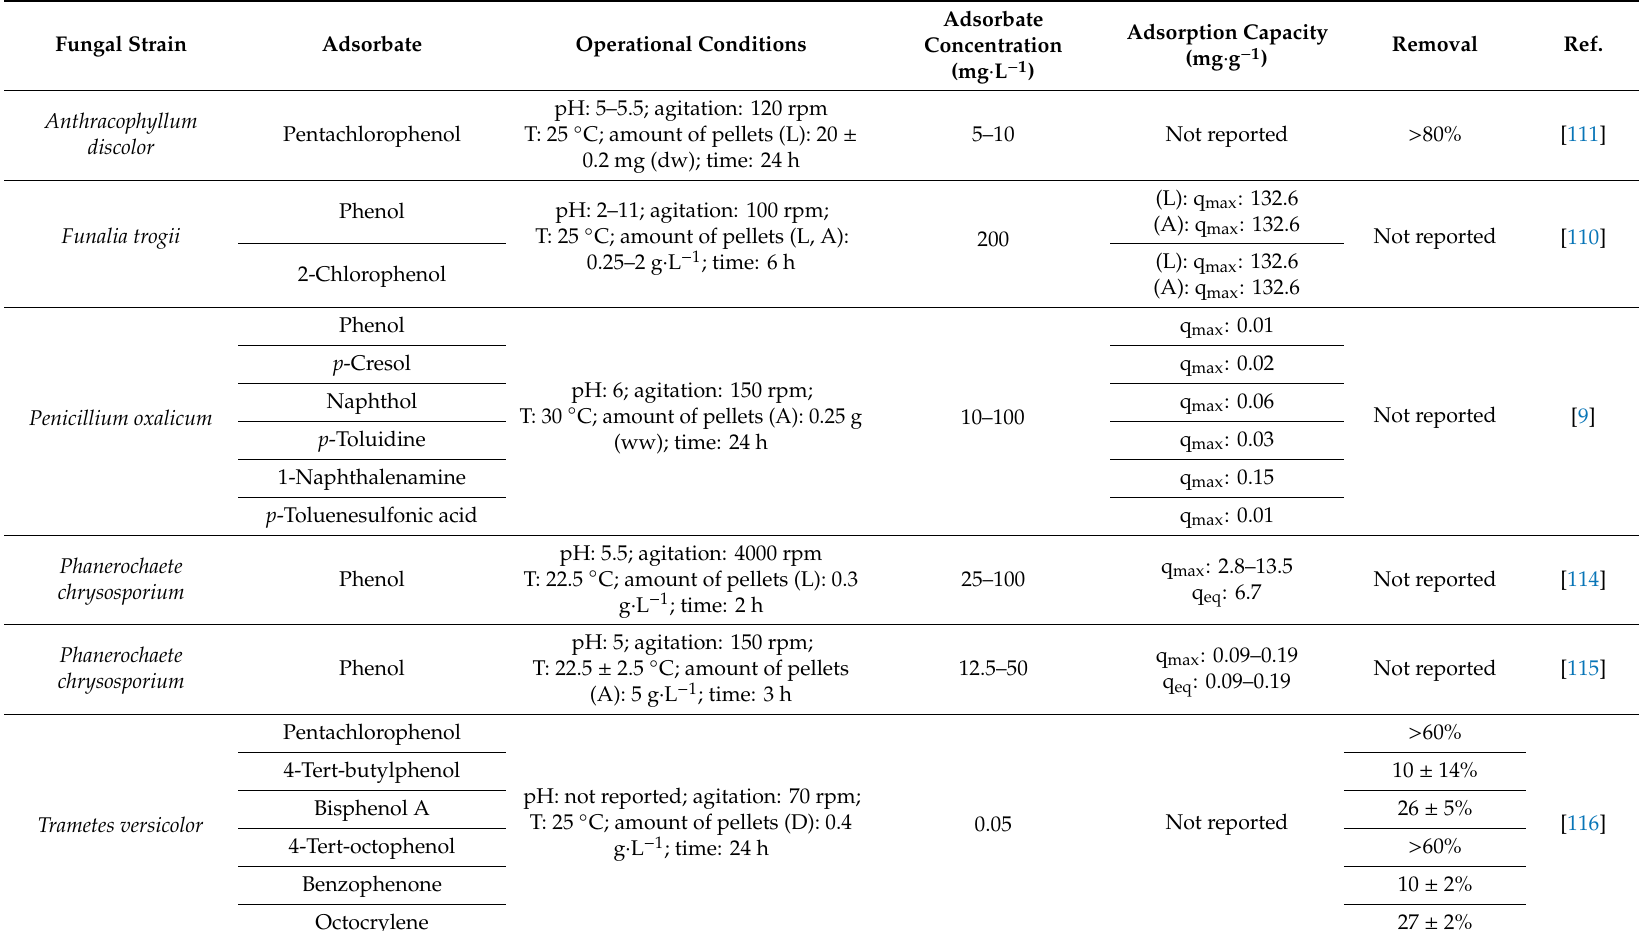
Table 4. Biosorption of phenolic compounds by fungal